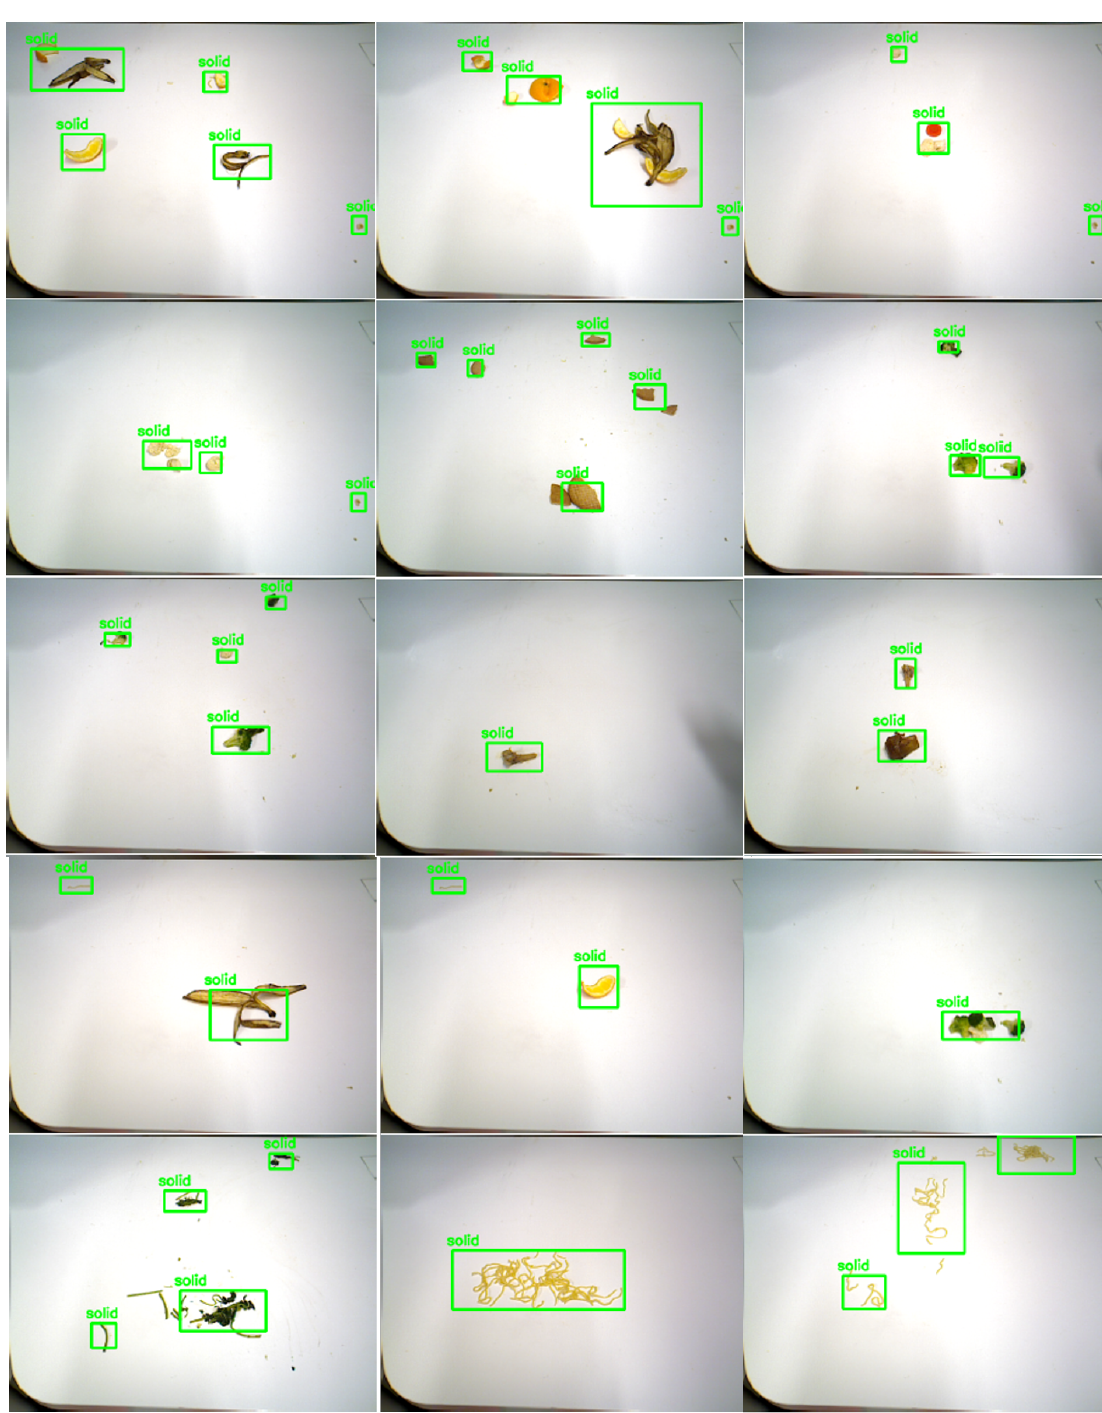
Figure 7. Solid litter detection